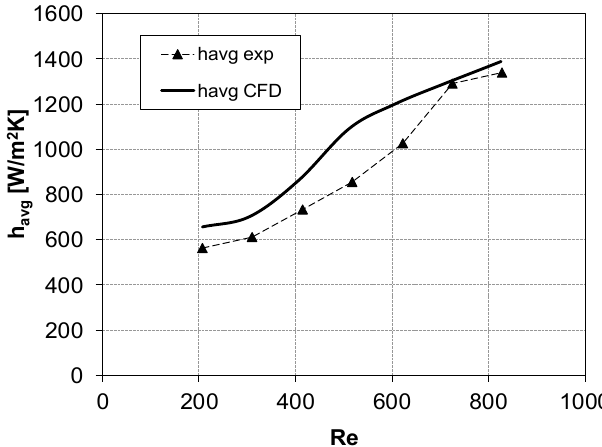
Figure 9. h avg vs Re for θ = 90°, α = 60° (configuration 2). Symbols denote the experimental results, while CFD results are represented by the thick solid line.